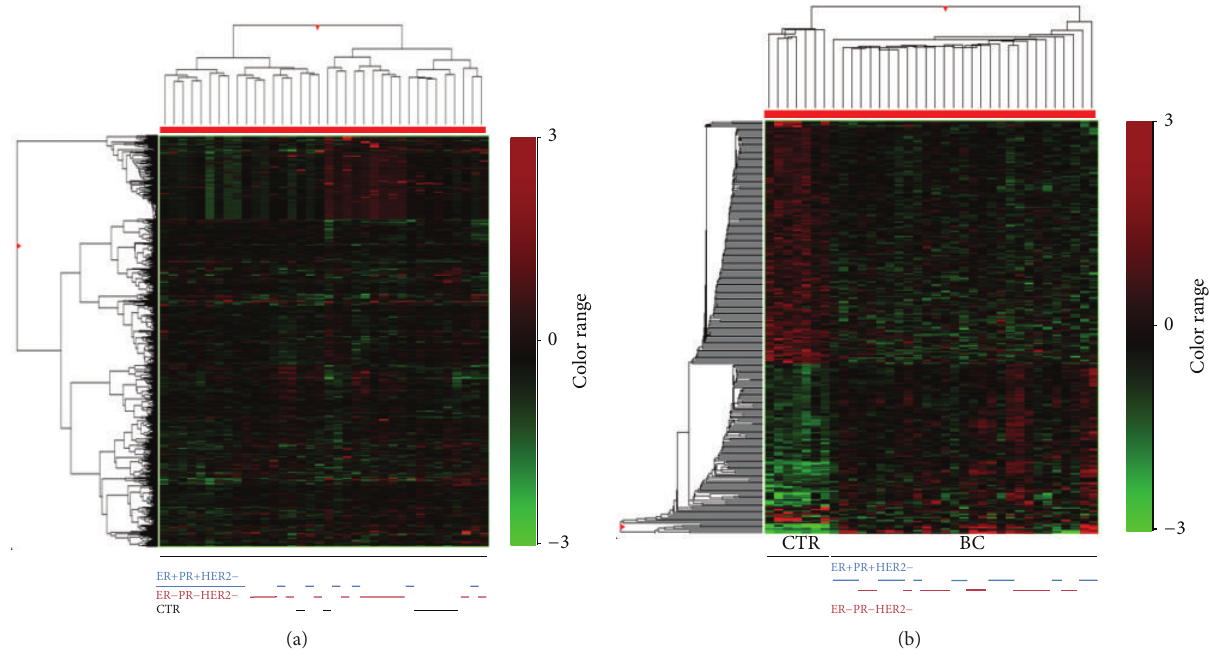
Figure 3: Unsupervised (a) and supervised (b) hierarchical clustering of blood samples from 29 BC and 7 CTR. The hierarchical clusters were computed using Euclidean distances and Ward method. The color indicates the level of mRNA expression: red, higher level of expression; green, lower level of expression; black, no expression change. All samples are represented by columns and genes by